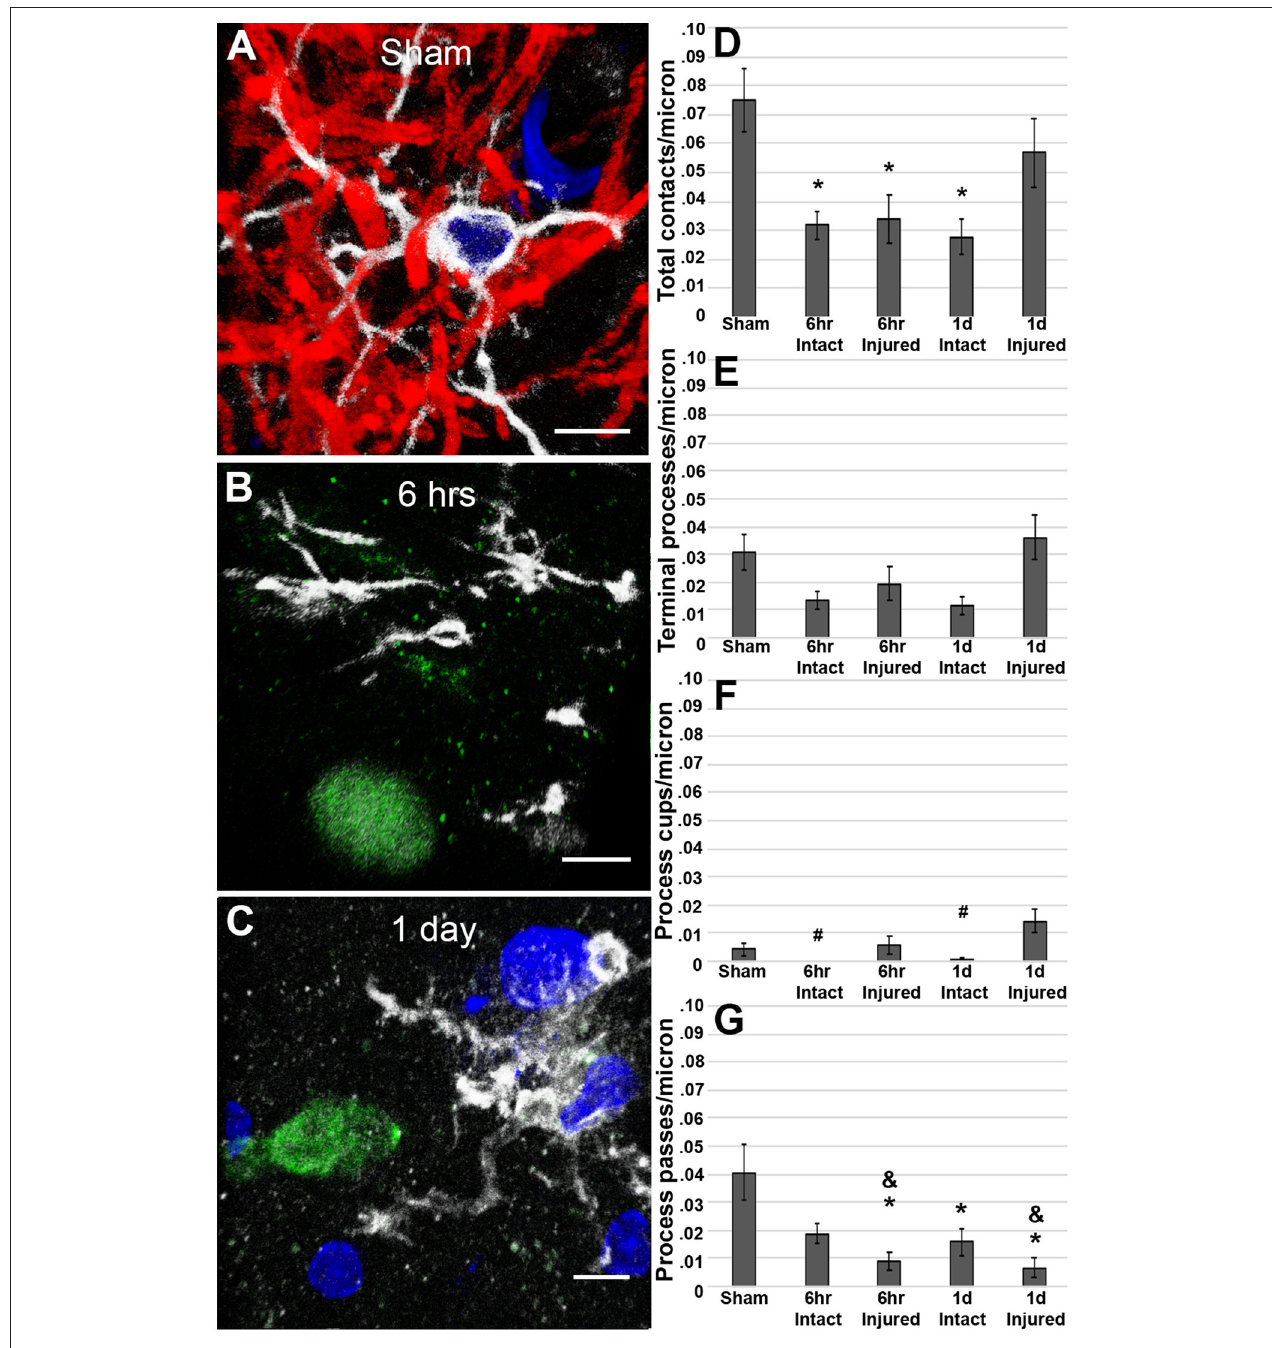
FIGURE 3 | Microglial processes are less engaged with axons following cFPI in the rat. Representative 3D reconstructions of Iba-1 + microglial (white) processes with (A) MBP + intact myelinated axons (red) in sham-injured rats or APP + injured axonal swellings (green) in cFPI rats either (B) 6h or (C) 1 day post-injury. DAPI-labeled nuclei are in blue. Bar graphs depicting the average number of (D) total microglial process contacts, (E) terminal processes, (F) process cups, and (G) process passes of Iba-1 + microglial that contact either MBP + intact fibers or APP + injured axonal swellings following sham or TBI in the rat. Note that overall, total microglial process contacts are decreased in intact axonal segments at both 6h and 1 day post-cFPI and in injured axonal swellings at 6h post-injury in rats. Graphs depict the mean ± standard error of the mean. * p < 0.05 compared to sham; # p < 0.05 compared to injured axonal swellings 1 day post-cFPI; & p < 0.05 compared to intact axonal segments 6h post-cFPI. Scale bar: 5 µ